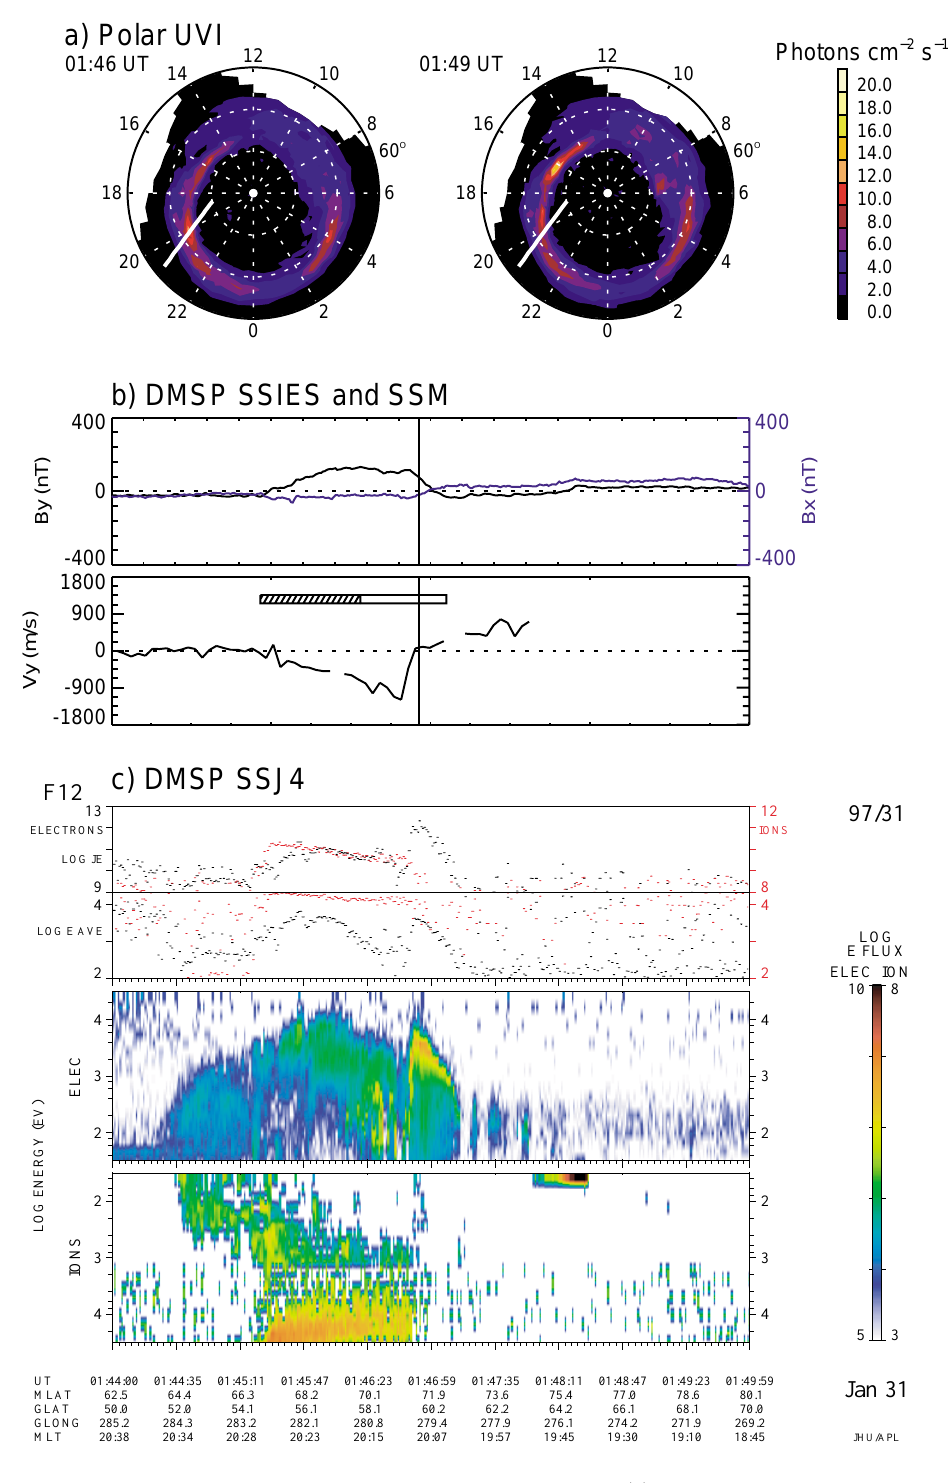
Fig. 2. A summary of observations for the 01:44–01:50 UT, 31 January 1997 event. (a) We selected two consecutive Polar UVI LBH-long auroral images which were closest to the period of the event. The white line on each image marks the trajectory of the DMSP F12 spacecraft, moving from the equatorside of the aurora to the poleward side. The both ends of the line denote the locations of DMSP at the beginning and the end of the event. (b) The black (blue) curve in the magnetic field panel represents variations of the Y and X components of the magnetic field produced by field-aligned currents. The vertical line in the B y /B x and convection ( V y ) panels denotes the location of the peak energy flux determined from (c) the DMSP electron energy flux data. The white (shaded) horizontal bar in the V y panel represents the interval of large-scale region 1 (region 2) field-aligned currents. Note that the + X component is in the direction of the spacecraft velocity vector. The + Y component is perpendicular to the + X component and points toward the nightside of the orbit